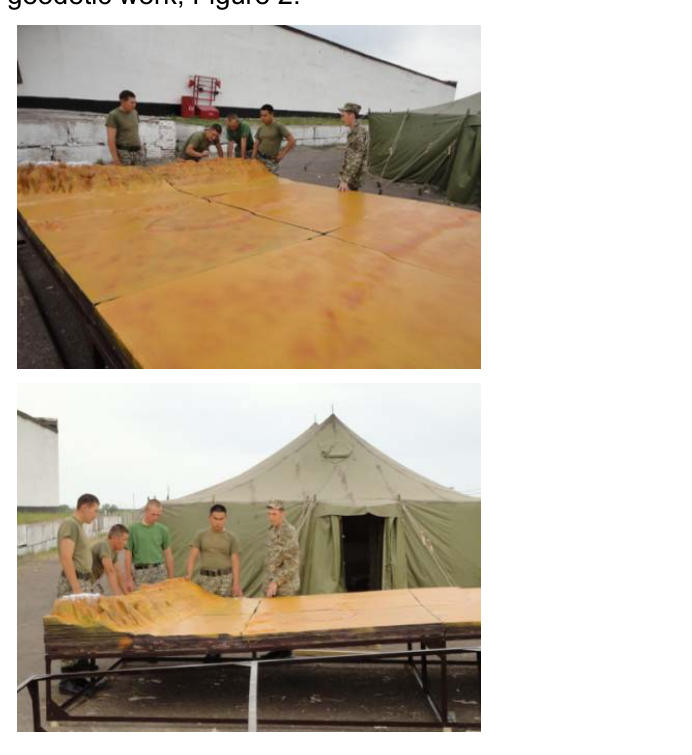
Figure 2 – Production of the terrain models by topographers of the Armed Forces of the Republic of Kazakhstan in